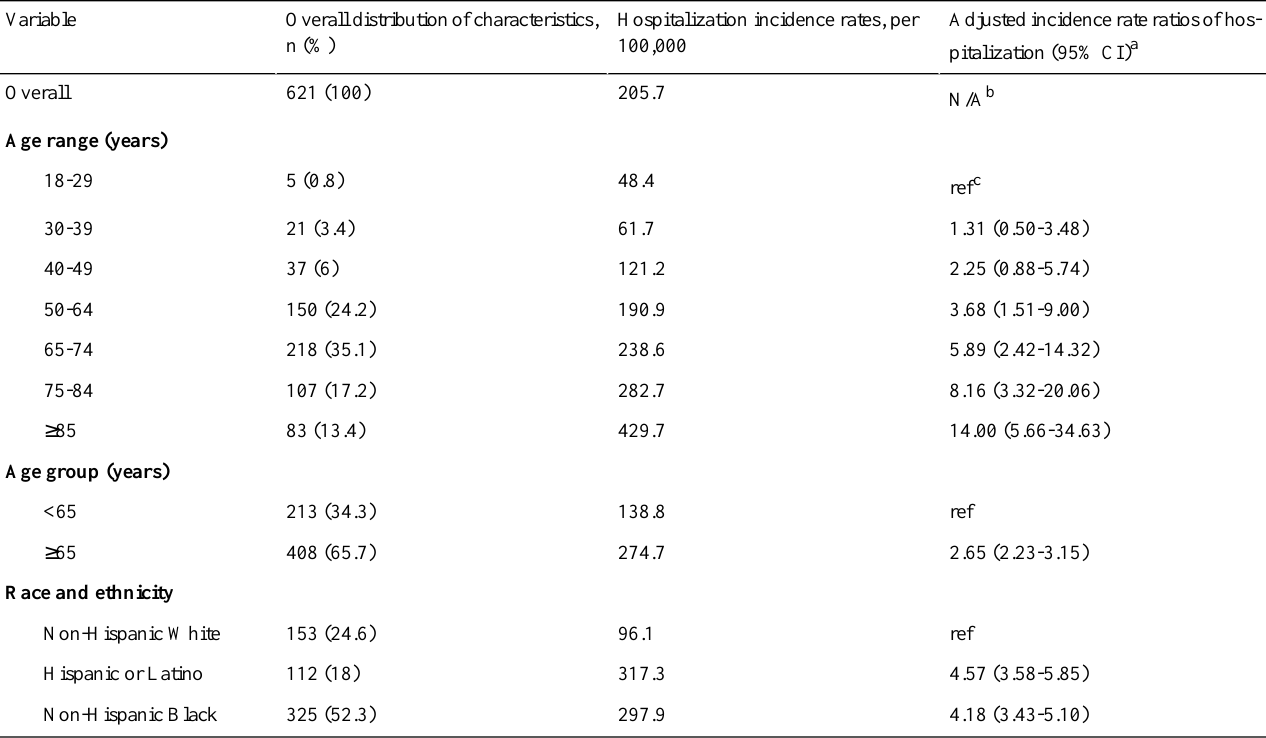
Table 1. Distribution characteristics, incidence rates, and adjusted incidence rate ratios of US veterans hospitalized with COVID-19—overall, by age, and by race and ethnicity, at 5 Veterans Affairs Medical Centers from February 27 to July 17,